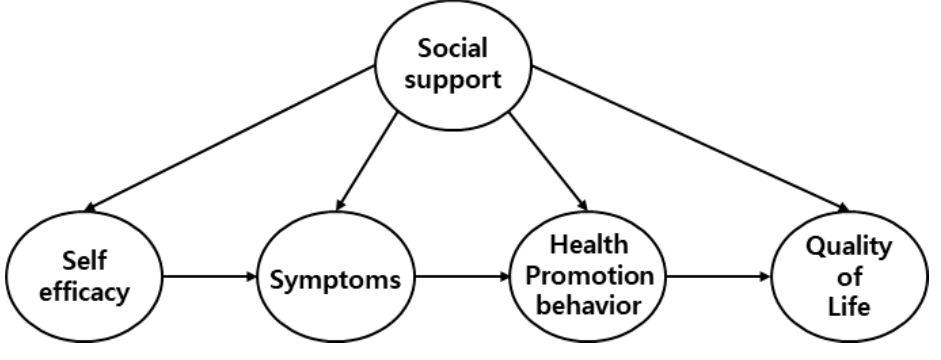
Figure 1. Conceptual framework of this study.